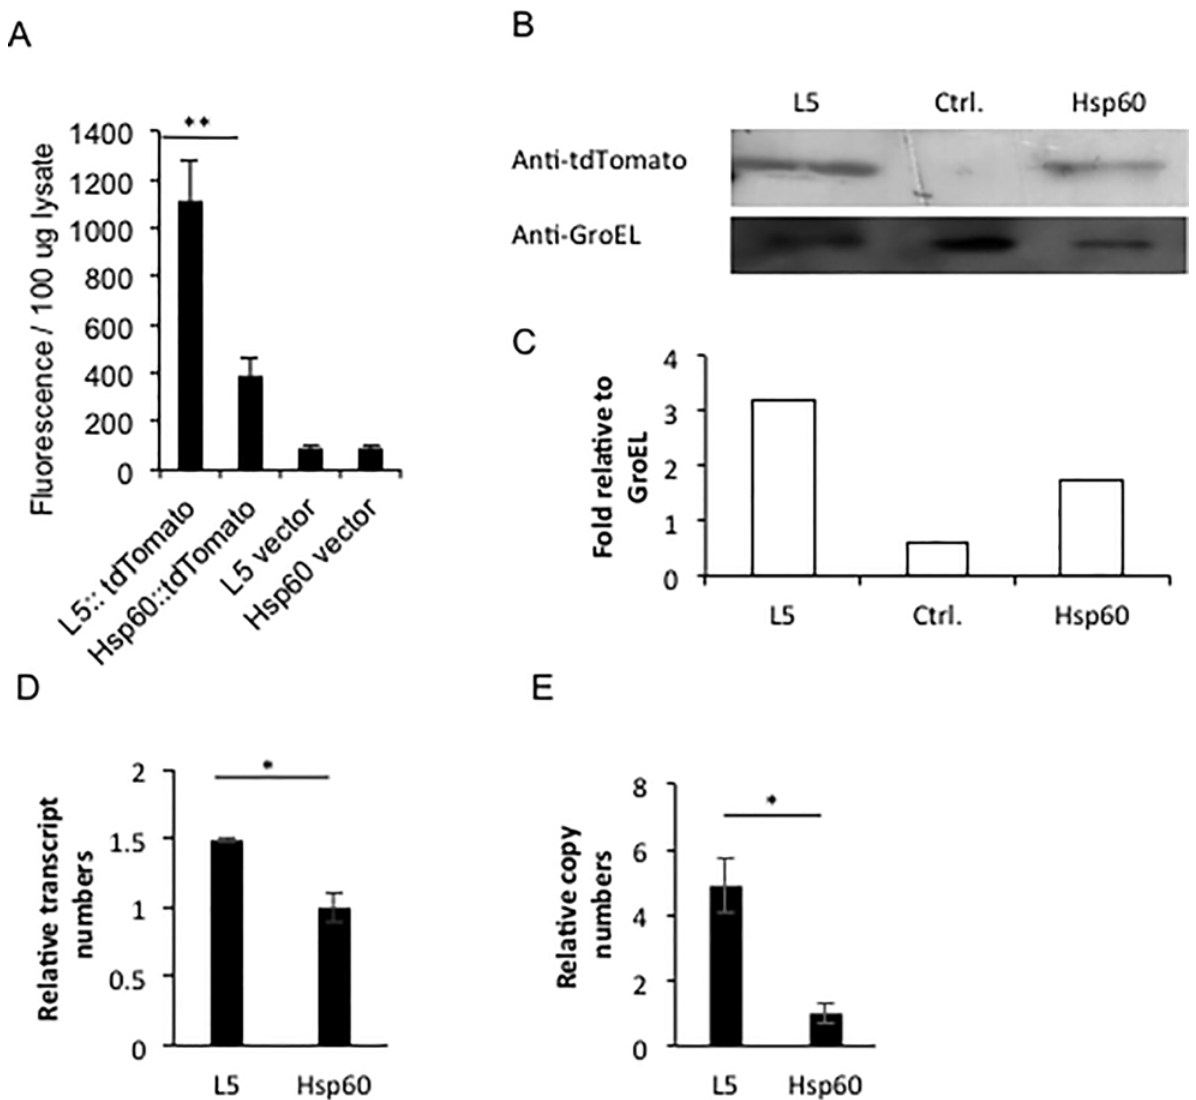
Fig 8. Comparison between L5-tdTomato and Hsp60-tdTomato M . bovis BCG strains in protein levels, transcript numbers and gene copies of tdTomato. A. Comparison of the fluorescence from supernatant of bacterial lysates between M . bovis BCG L5-tdTomato and Hsp60-tdTomato strains. M . bovis BCG L5-tdTomato and Hsp60-tdTomato strains were grown until OD 6 bacteria/ml were ultrasonically lysed in 1x PBS with 0.1% Triton X- 600 = 0.75. 10 100. After centrifugation, the supernatant from the samples was compared using a multimode reader with 530 nm excitation and 590 nm emission wavelengths. B. Western Blotting to compare tdTomato protein levels expressed from an L5 promoter with that expressed from the Hsp60 promoter. The strain carrying the Hsp60 vector was used as a negative control. Bacterial housekeeping gene GroEL2 was used as the loading control. C. Quantification of relative band intensities in D by densitometry. D. Real time RT-PCR to compare transcripts of tdTomato expressed from the L5 promoter with transcripts levels expressed from the Hsp60 promoter. E. Real time q-PCR to compare copy numbers of tdTomato expressing plasmid with the L5 promoter and that carrying the Hsp60 promoter. Data represent one of three replicate experiments. Student ’ s t-test was performed to examine difference between the L5-tdTomato and Hsp60-tdTomato strains in fluorescence of extracted protein, transcript numbers and gene copies. * represents P < 0.05; and ** represents P <